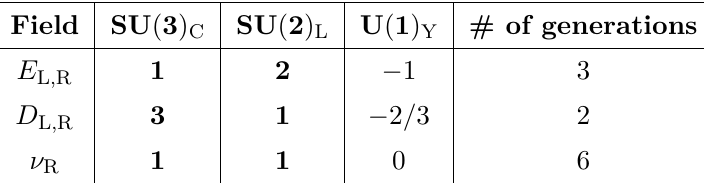
Table 2. Beyond-the-SM sector for the fermions and quarks.